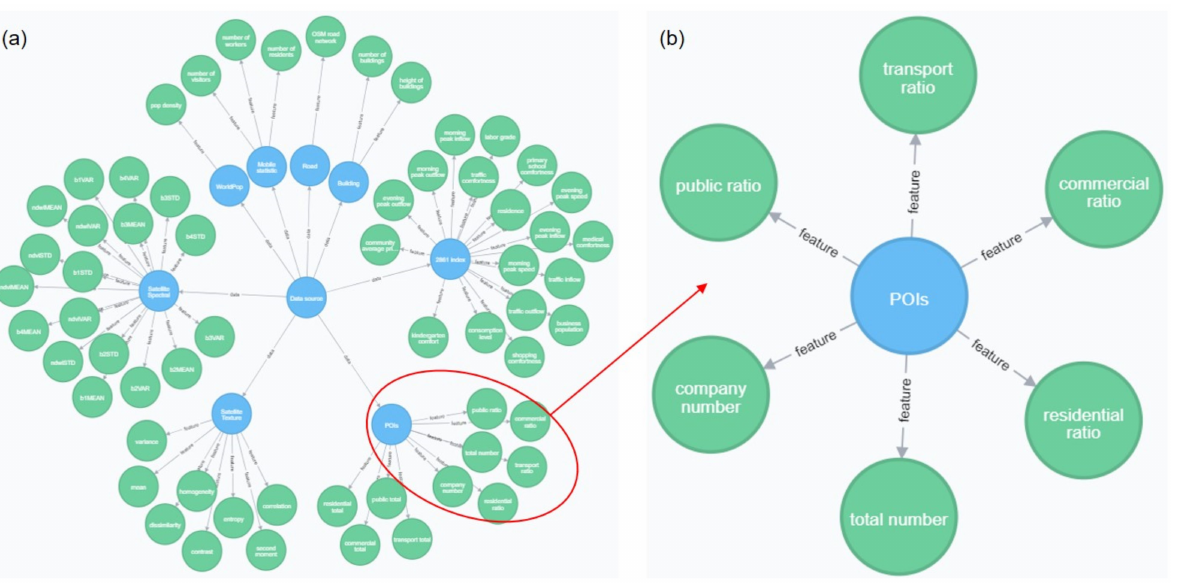
Figure 8. ( a ) Ontology description of CMU data sources; and ( b ) zoomed-in area of the red